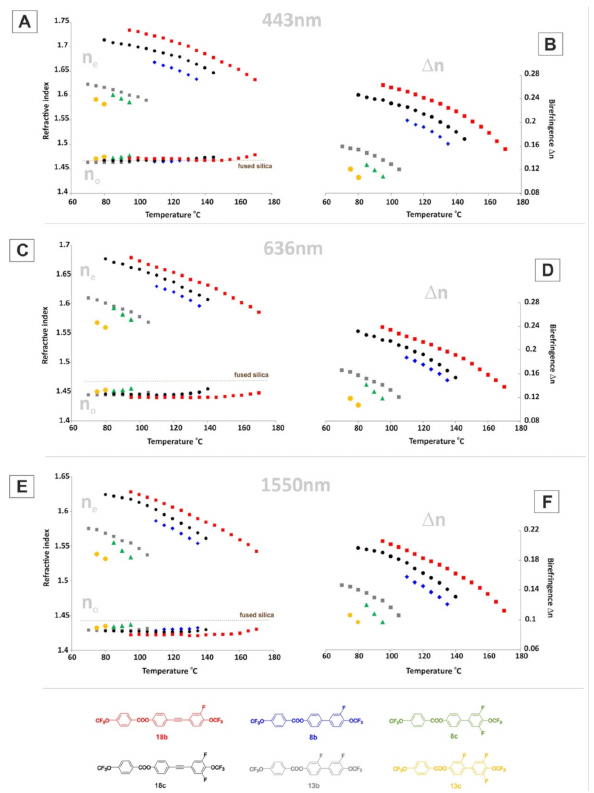
Figure 14. Temperature dependence of refractive indices n o and n e ( A , C , E ) and birefringence ∆ n ( B , D , F ) measured for 8b , 8c , 13b , 13c , 18b , and 18c at λ = 443, 636, and 1550